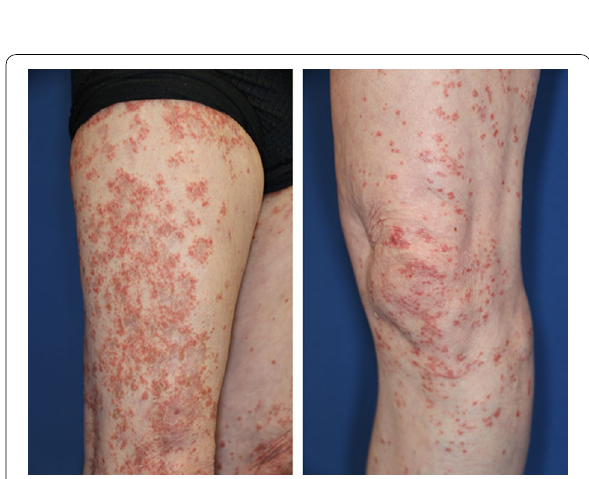
Fig. 2 GVHD-like erythroderma. Erythema appeared on the extremities and body